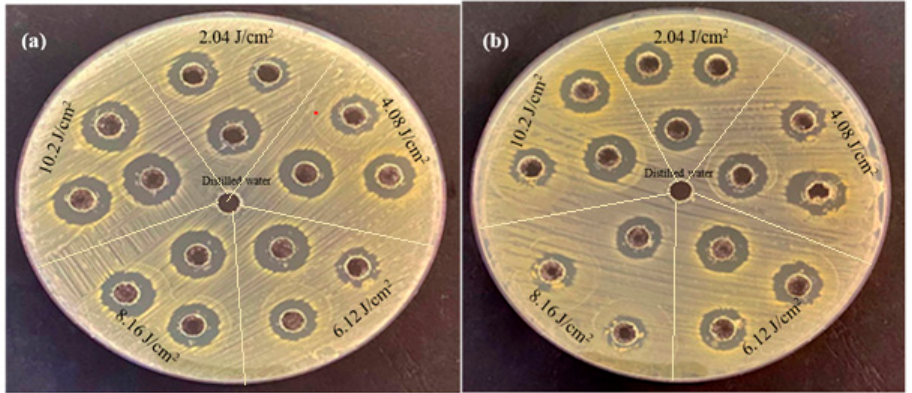
Figure 7. The antibacterial activity of palladium nanoparticles (Pd NPs) prepared by pulsed laser ablation of palladium target in DI water with different laser fluences against bacterial strains ( a ) E. coli and ( b ) Staphylococcus aureus. Table 2. The antibacterial activity of palladium nanoparticles (Pd NPs) prepared by pulsed laser ablation of palladium target in DI water with different laser fluences against E. coli and Staphylo- coccus aureus bacterial strains.